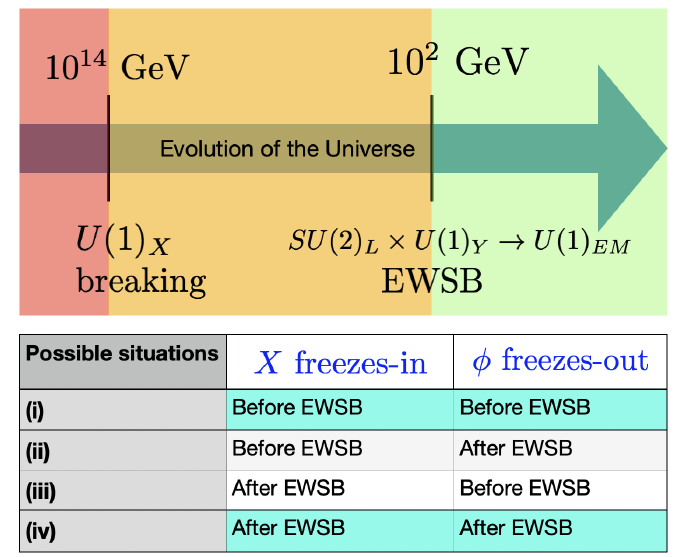
Figure 2 . The relevant symmetry breaking scales of the model: U(1) X breaking and EWSB (top panel) and different phenomenological situations for X to freeze-in and φ to freeze-out (bottom